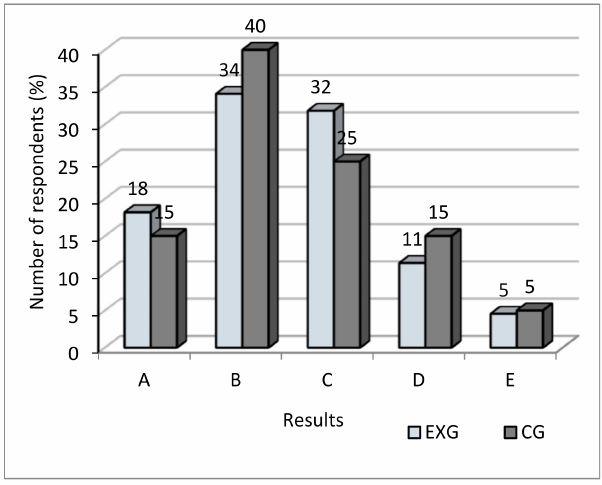
Figure 1. Pre-test